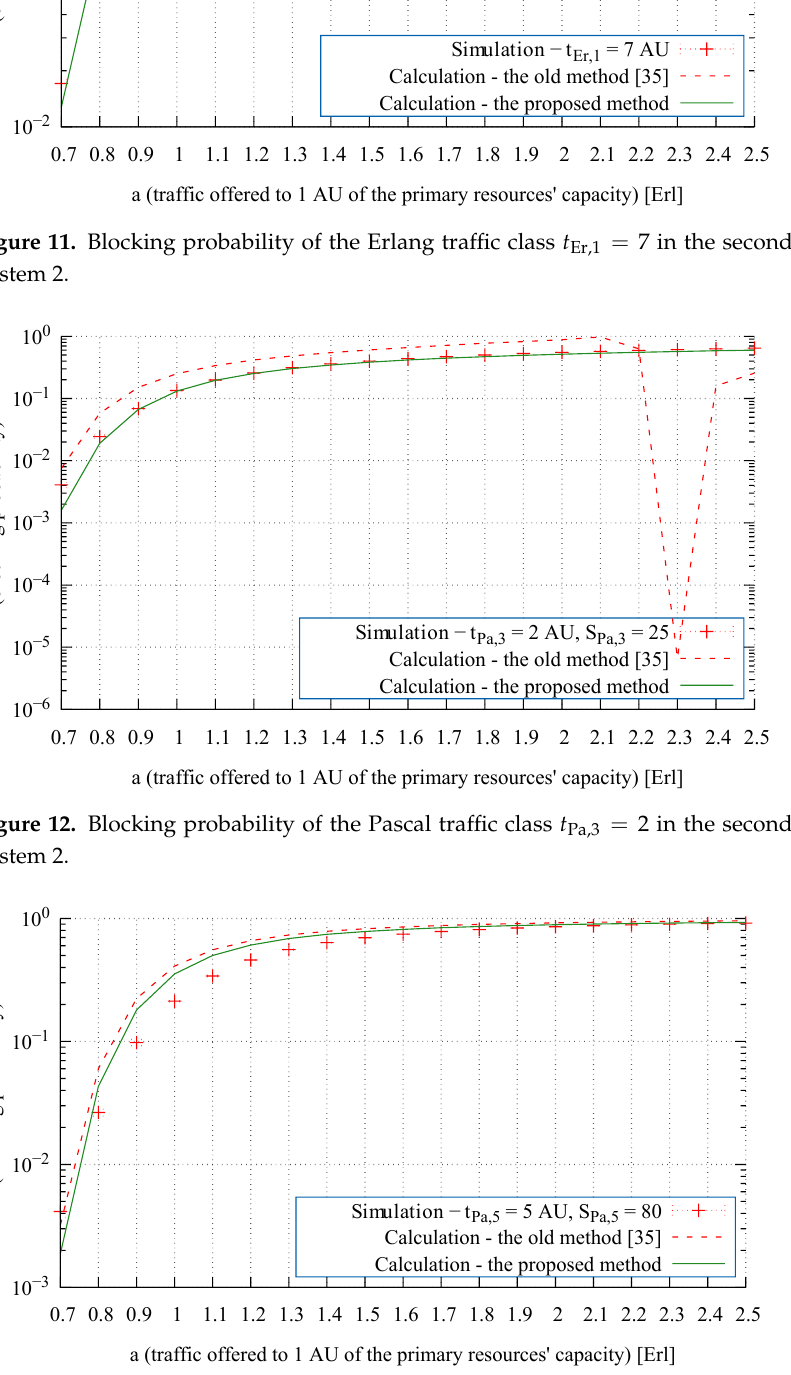
Figure 13. Blocking probability of the Pascal traffic class t Pa,5 = 5 in the secondary resources in System